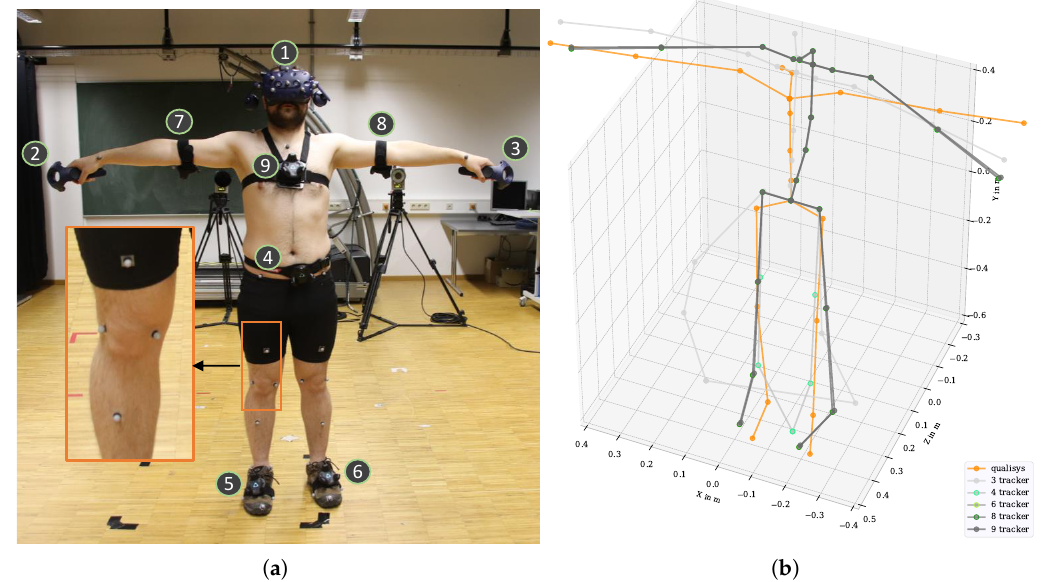
Figure 3. Setup of simultaneous motion measurements with the Qualisys system and the Vive system with different tracker configurations. ( a ) A participant in T-position with attached markers for the Qualisys system and Vive track- ers, specified with the numbers 1–9. ( b ) A body skeleton based on the Qualisys system and on different Vive tracker